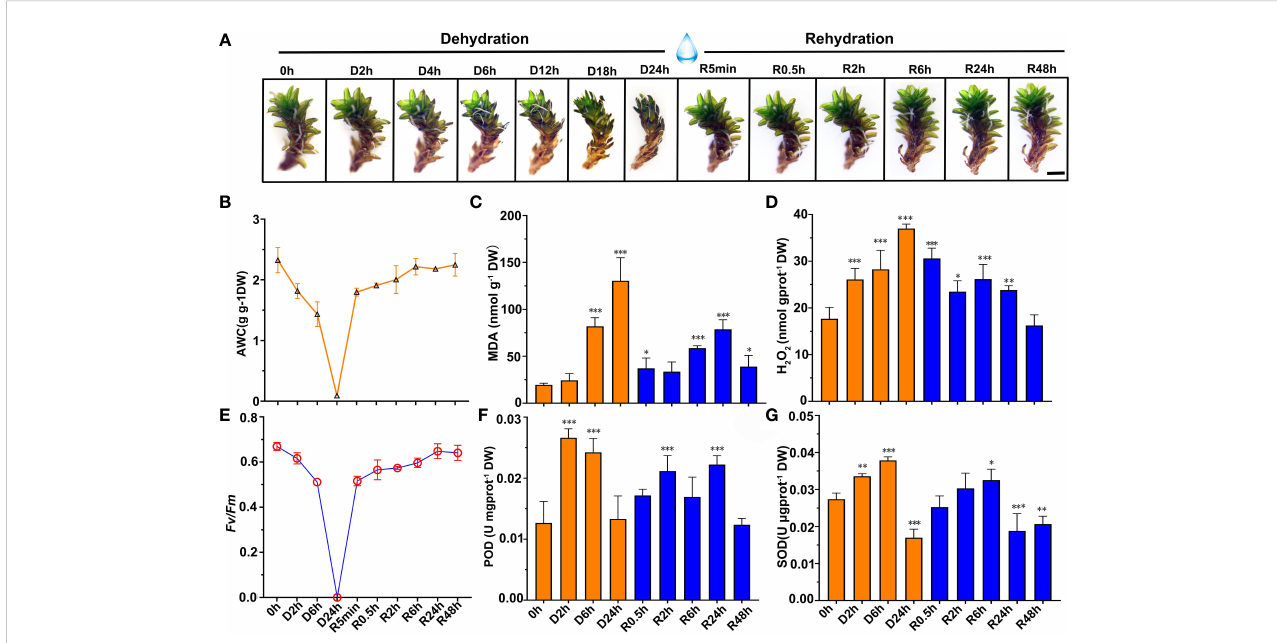
FIGURE 1 Phenotype, physiological parameters change of S. caninervis under D-R treatments. (A) Phenotype of S. caninervis under D-R conditions, scale bars: 2 mm; (B) AWC; (C) Fv/Fm ; (D) MDA content; (E) H 2 O 2 content; (F) POD activity and (G) SOD activity; treatments during 24 h of desiccation (D h) and 48 h of rehydration (R h); data represents the mean ± SD from six biological replicates.* p < 0.05, ** p < 0.01, *** p < 0.001, Fisher ’ s least signi fi cant difference